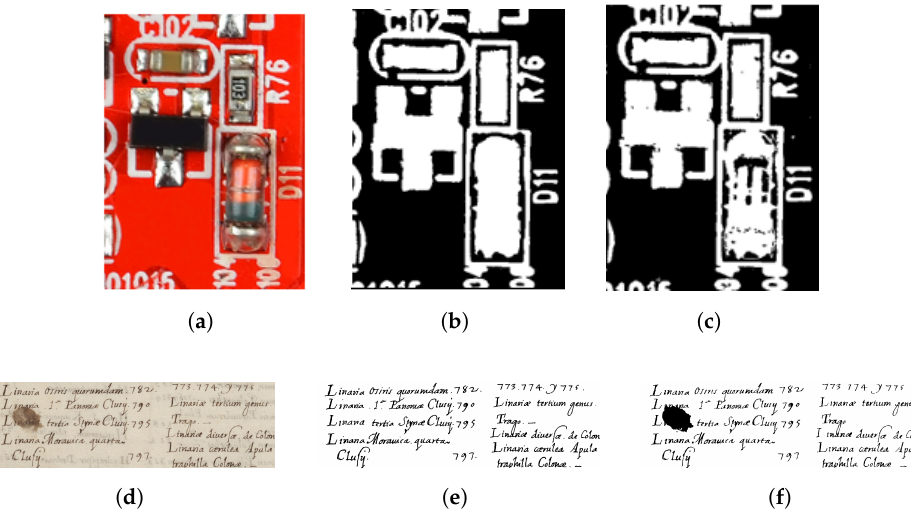
Figure 11. Thresholding results of images with simlarly colored foreground or background regions. Left column: input image. Centre column: ground truth. Right column: image thresholded by the proposed method. The red-colored component D11 in ( a ) is misclassified as the background in ( c ), based on the ground truth ( b ). Ink stains in the input text image ( d ) are misclassified as foreground in ( f ). Images ( d – f ) were taken from the DIBCO database